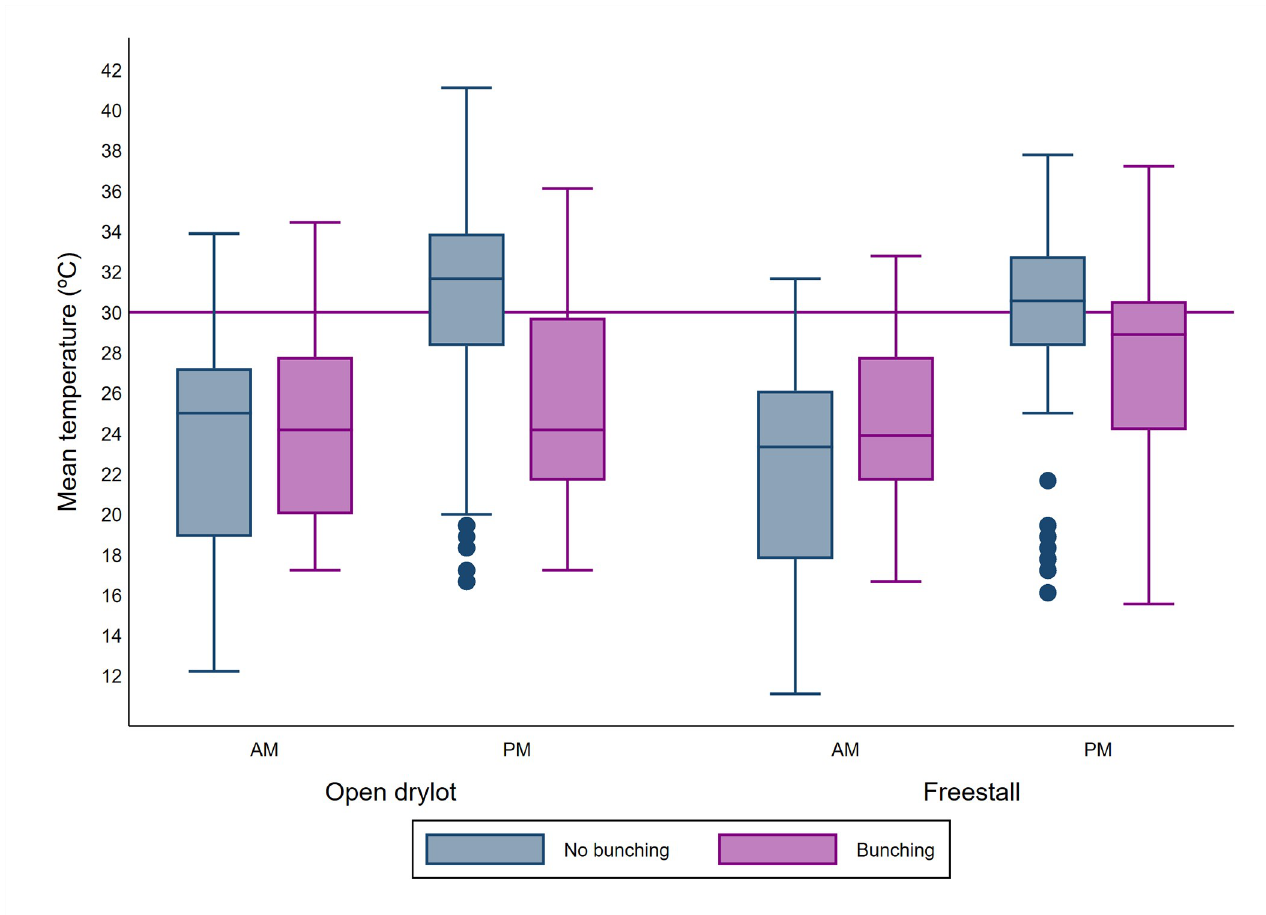
Fig 4. Boxplot of average trap count, bunching and farm design. The upper and lower horizontal lines of the box represent the 25 th and 75 th percentiles respectively, the horizontal midline represents the median, the upper and lower horizontal whiskers lines are the upper and lower limits and the dots are the